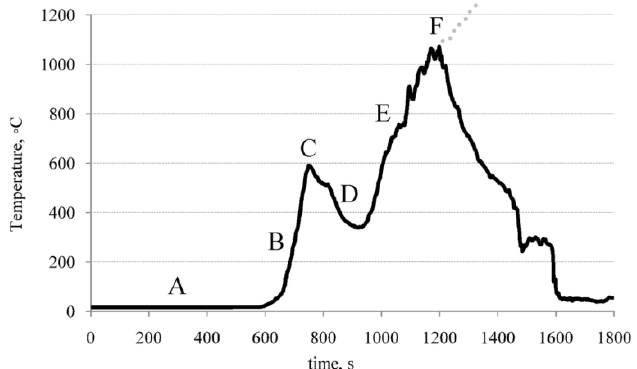
Figure 13. The phases of sofa fire marked at the temperature curve (the second fire test, tree no. 2, height 2.4 m in Figure 6) (description in text).